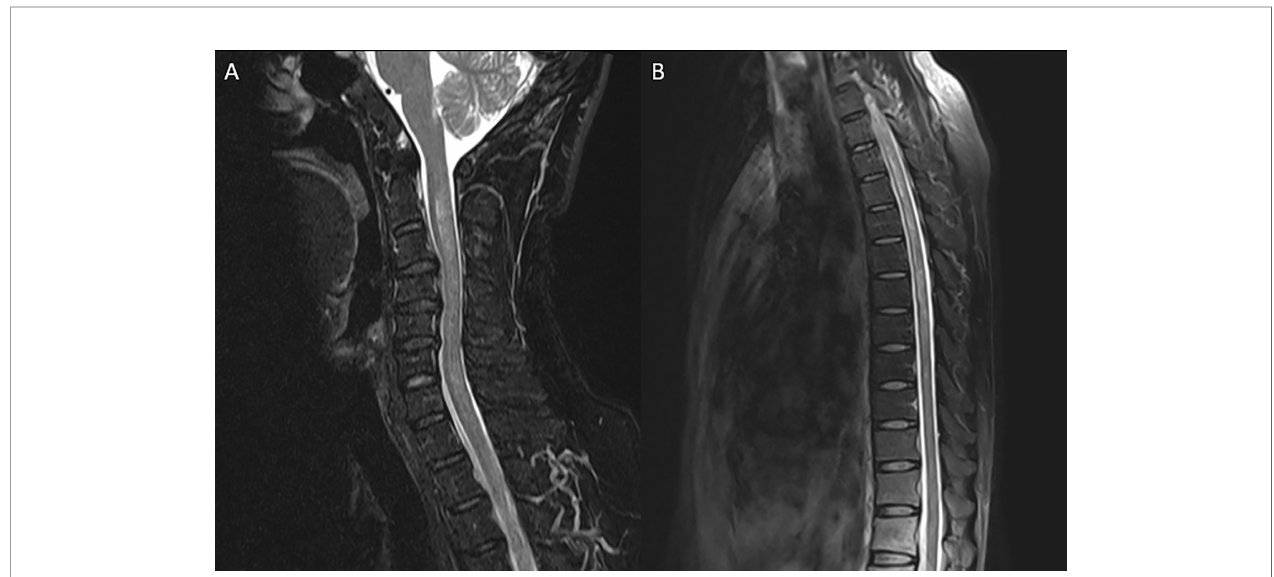
FIGURE 1 | Magnetic resonance imaging of the cervical (A) and thoracic (B) spinal cord. Sagittal T2-weighted imaging showed longitudinally extensive hyperintense lesion extending from C2 to